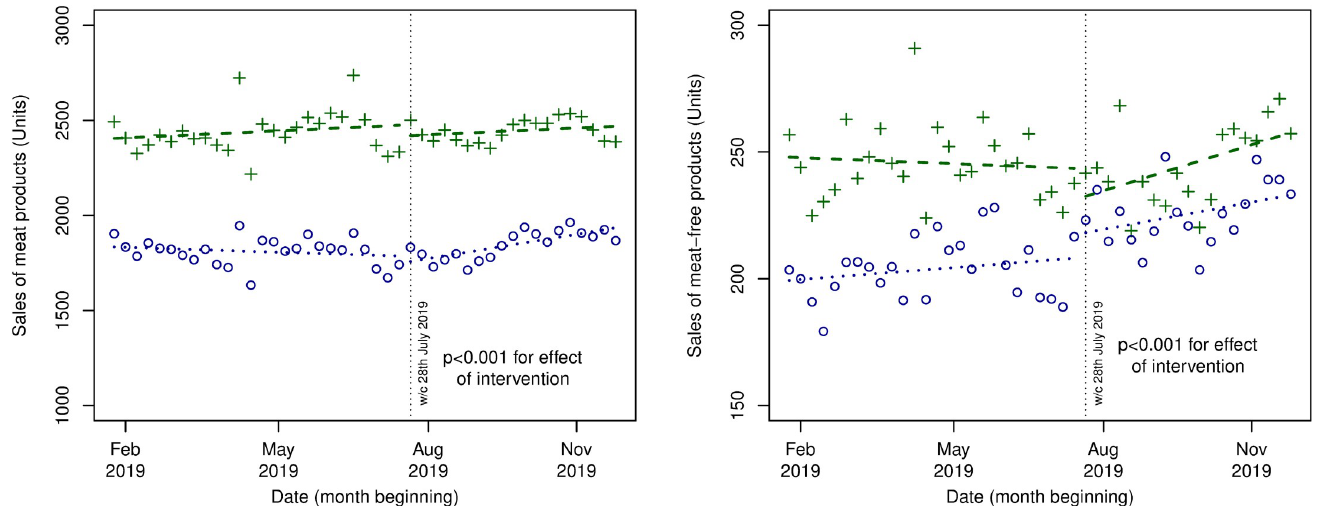
Fig 3. Interrupted time series analysis showing level and trend changes in sales (units) of meat and meat-free products before and after Phase II intervention period (week commencing July 28, 2019) in Phase I stores ( n = 12) and Phase II stores ( n = 8). � Green crosses denote intervention Phase I stores, and blue dots denote intervention Phase II